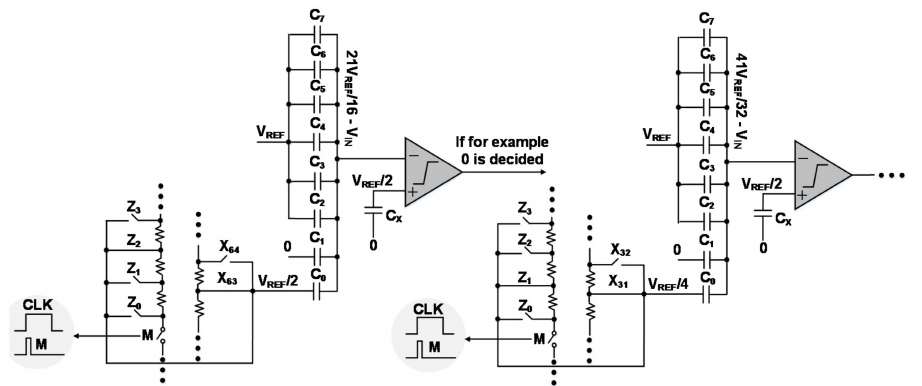
Figure 9. Example of MSB-3 and MSB-4 bit decision when the three MSBs are 110. CLK: clock; M: switch